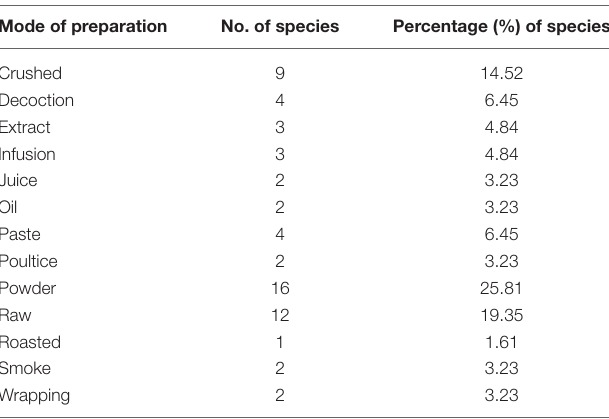
FIGURE 4 | Plant species parts used in preparation of indigenous medicines. TABLE 3 | Modes of preparation of the recorded species used in indigenous